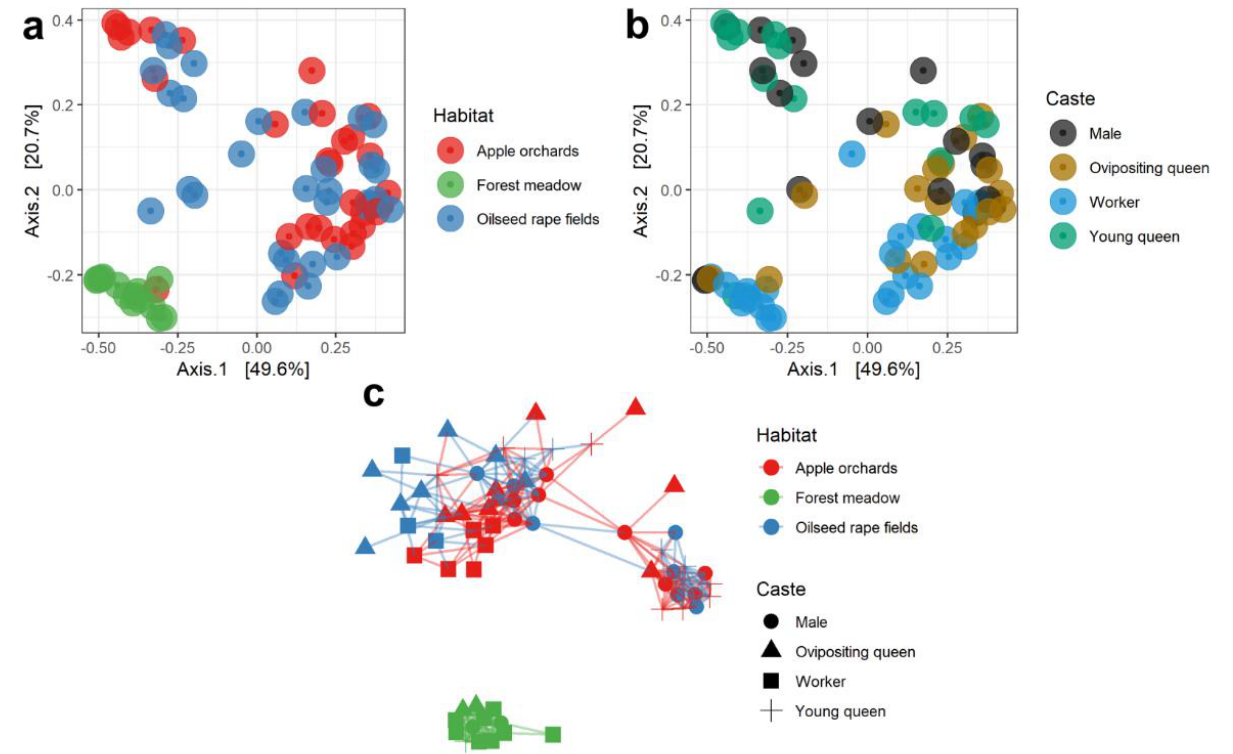
Figure 3. Metric multidimensional scaling (MDS/PCoA) on weighted UniFrac distances of the gut bacterial community from Bombus terrestris specimens collected from three habitat types ( a ) and from four castes ( b ). ( c ) Network analysis of B. terrestris gut bacterial community clustering by habitat, based on the Bray–Curtis dissimilarity matrix. Distance between different points on the plot reflects similarity level: the more similar the communities, the smaller the distance between the points.